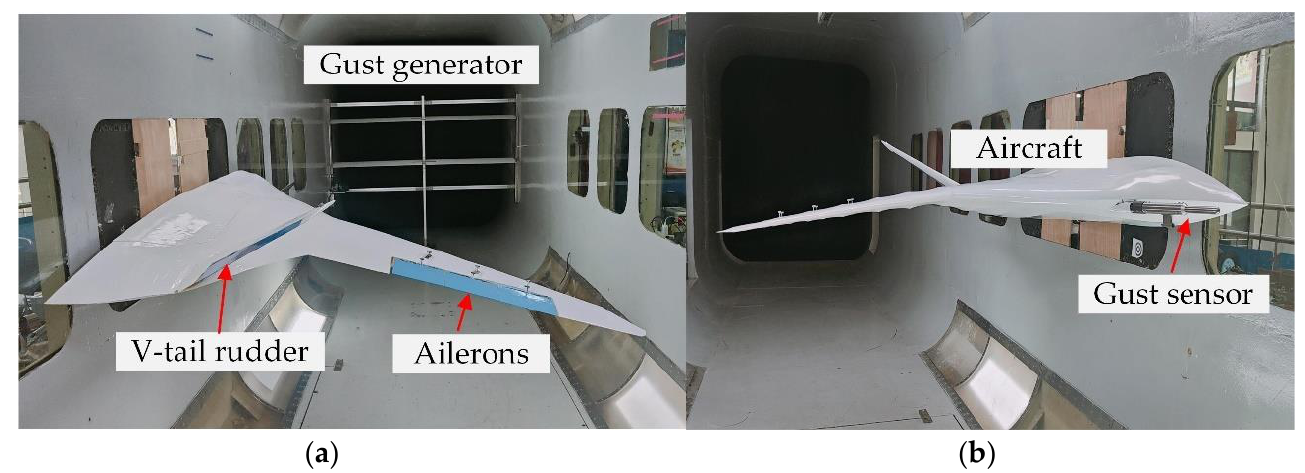
Figure 19. Aircraft model installed in wind tunnel. ( a ) Rear view of model and ( b ) front view of model.